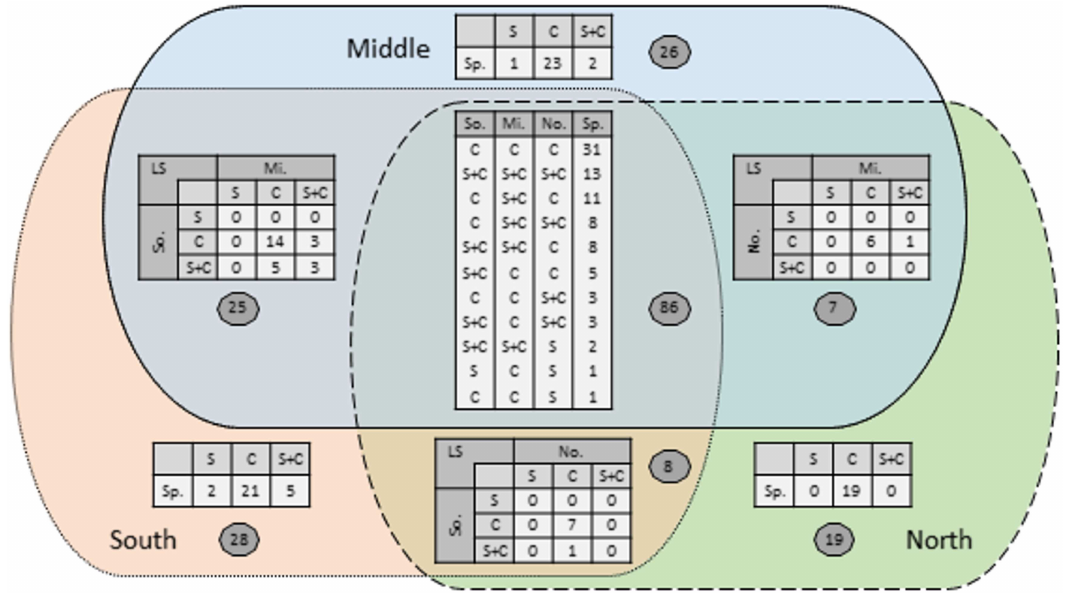
Fig 2. Species distribution in the three landscapes. Venn diagramindicatingthe numberof species (Sp.) found exclusivelyin the south (So.), middle (Mi.) and north (No.) landscapes (LS), shared by any two landscapes, and shared by all three landscapes. In each area, the embedded tables indicatethe species that occurredonly in simple habitats (S), only on complex habitat (C) or in both simple and complexhabitats (S+C).